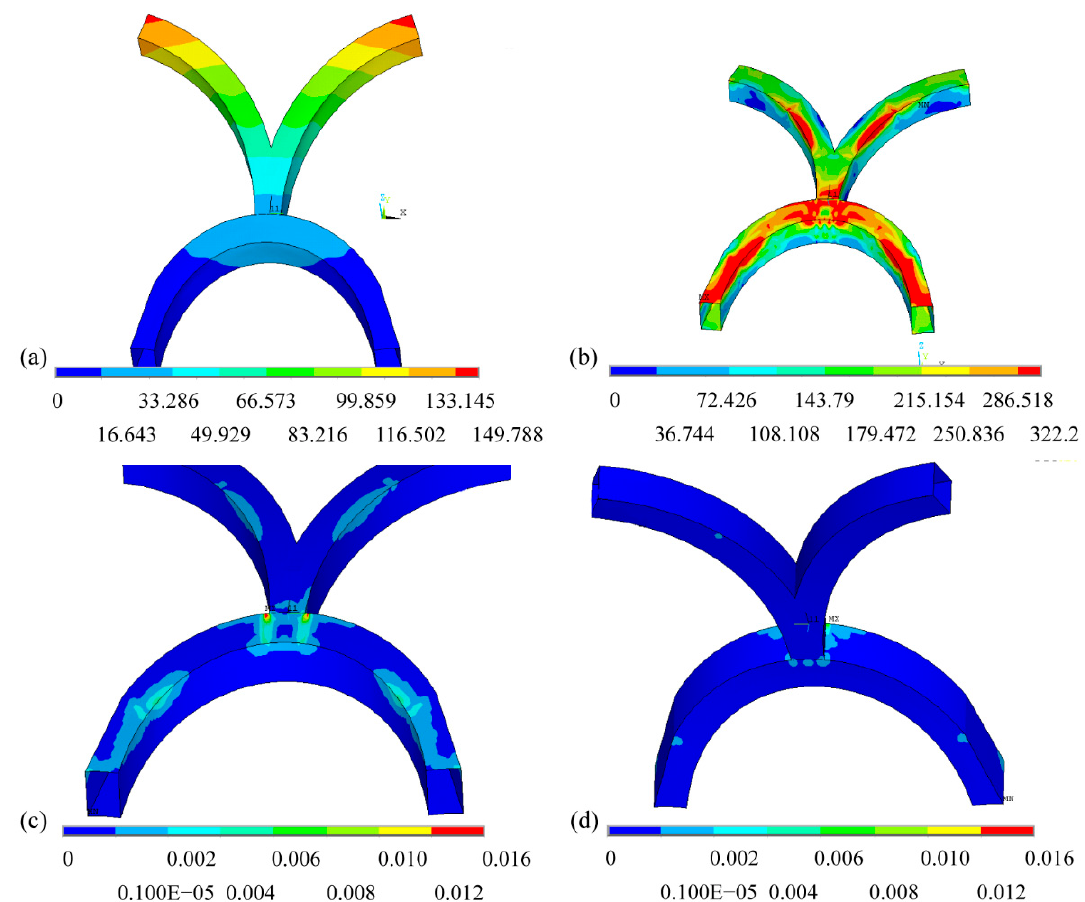
Figure 5. ( a ) Displacement, ( b ) Mises stress, and plastic strain in the ( c ) top and ( d ) bottom parts of the web for the initial